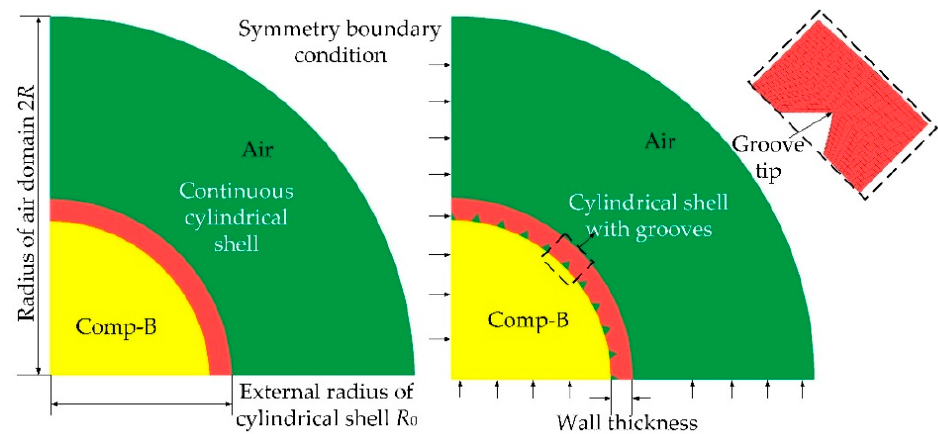
Figure 4. Simulation model of cylindrical shells with discontinuity and no discontinuity under internal explosive loading.